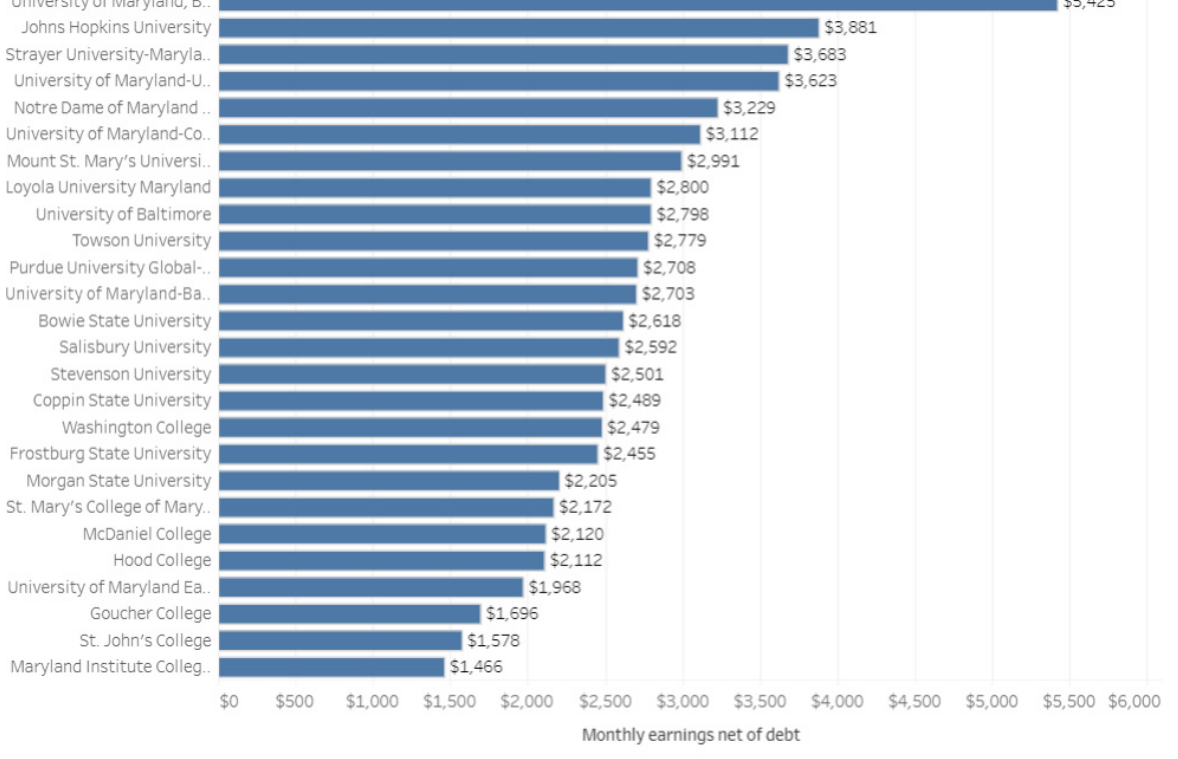
Figure 5. First Year Monthly Expected Earnings Net of Debt Payments for Bachelor’s Degrees, Colleges and Universities in the State of Maryland. Source: Buyer’s Beware Interactive Tool, based on Carnevale et al.